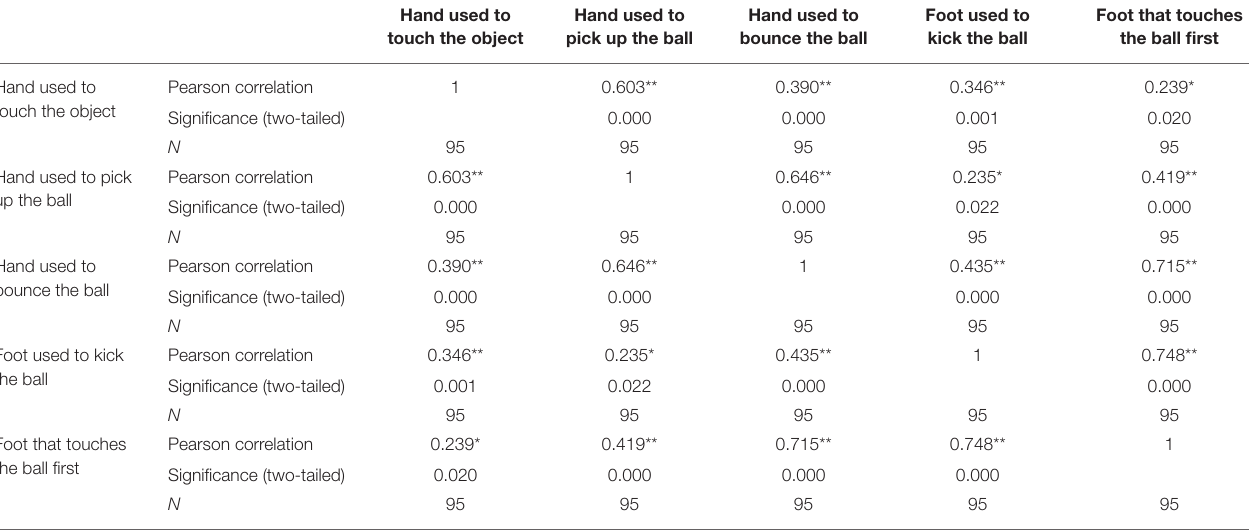
Hand used to touch the object